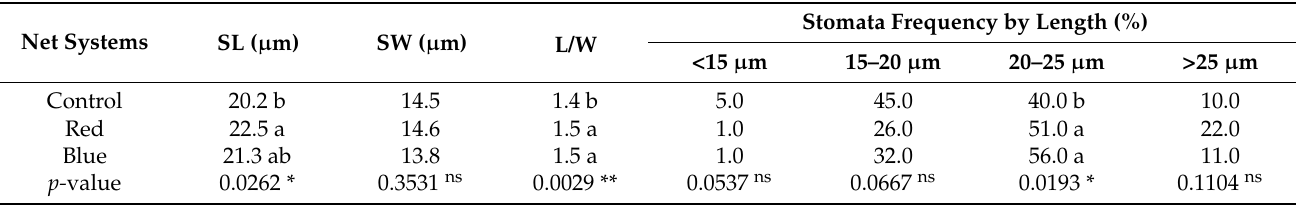
Figure 3. ( a ) Scanning electron micrograph of stomata characteristics in apple leaves under white (control), ( b ) red and ( c ) blue colored nets. Magnification 503×. White Bars = 100 µm. Table 2. The influence of Red and Blue netting on stomata length (SL), stomata width (SW), length to width (L/W) ratio and stomata frequency in ‘Fuji’ apple leaves.